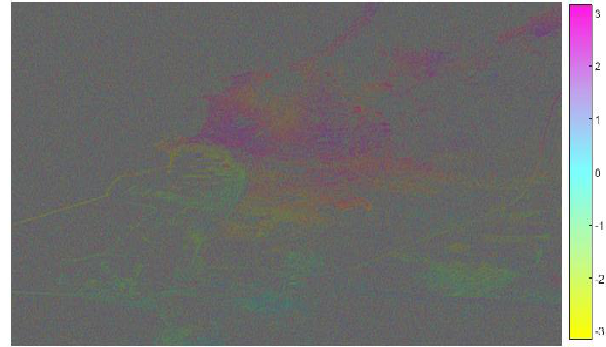
Figure 6. Flattened interferometric phase corresponding to the Constanta test region, interferometric pair: 20 December 2015–28 August 2015.